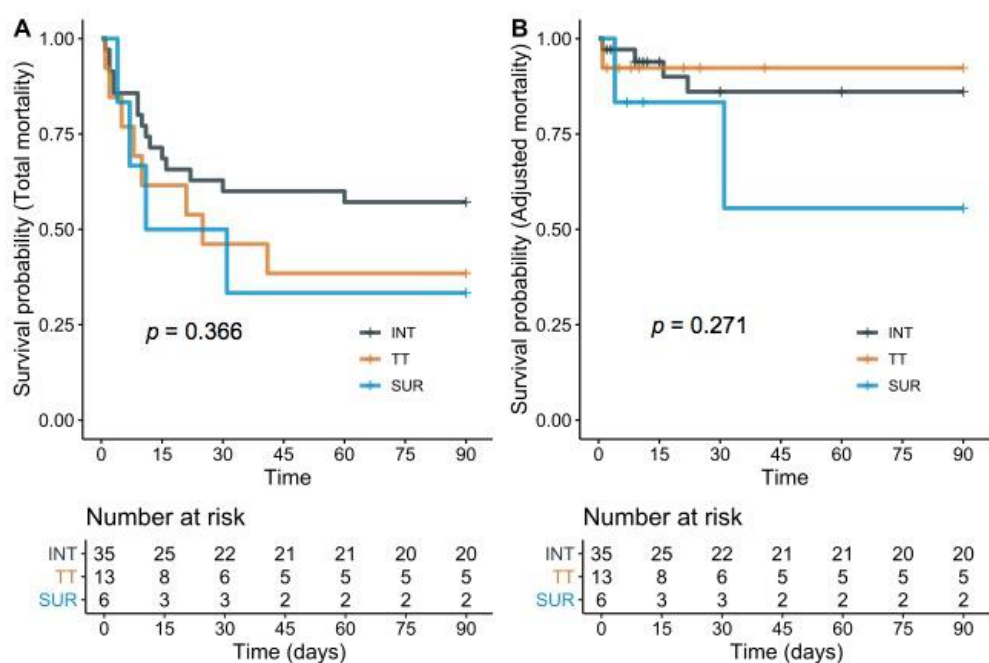
Figure 1. Kaplan–Meier survival probability related to causative events. Tracheal intubation-related (INT); tracheotomy-related (TT); surgery-related (SUR); p -value ( p ). Causes of iatrogenic tracheal rupture were comparable in all-cause mortality-free survival (Figure 1A; log-rank p = 0.366) and adjusted mortality-free survival (Figure 1B; log-rank p = 0.271).